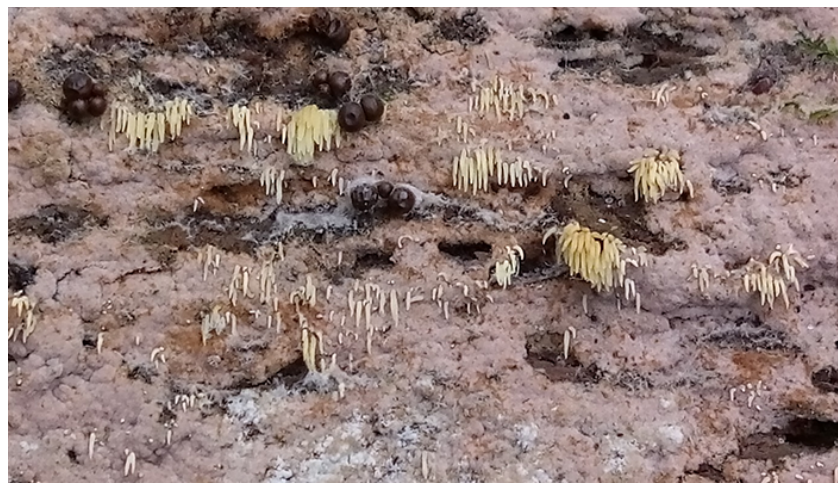
Figure 10 Basidiomata of Mucronella flava Corner on basidiomata of Botryobasidium isabellinum (Fr.) D. P. Rogers. Photography by Anna